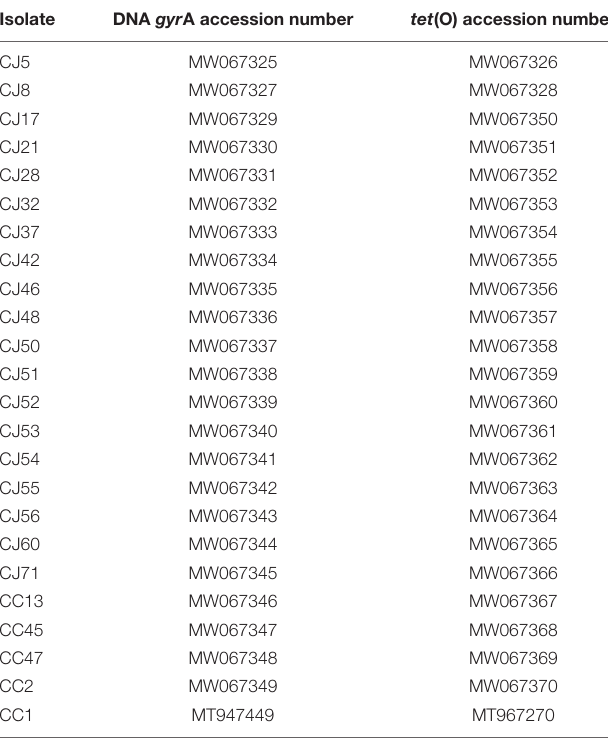
TABLE 2 | Accession numbers for DNA gyr A and tet (O) resistance genes. Isolate